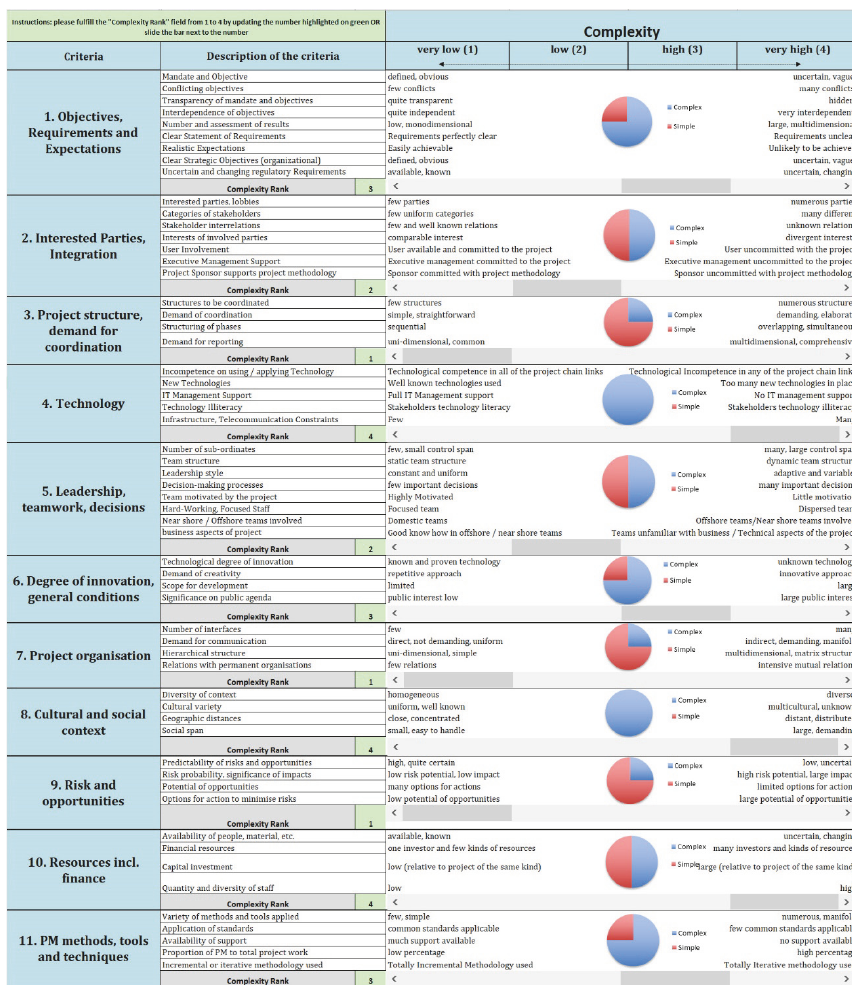
Figure 4: Complexity Index tool interface.